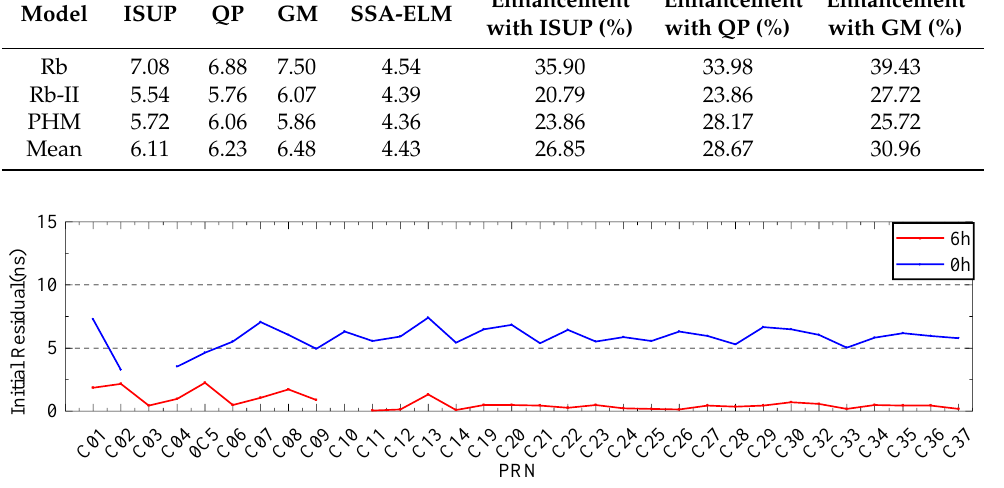
Figure 19. The initial residual value with a DOY of 196.